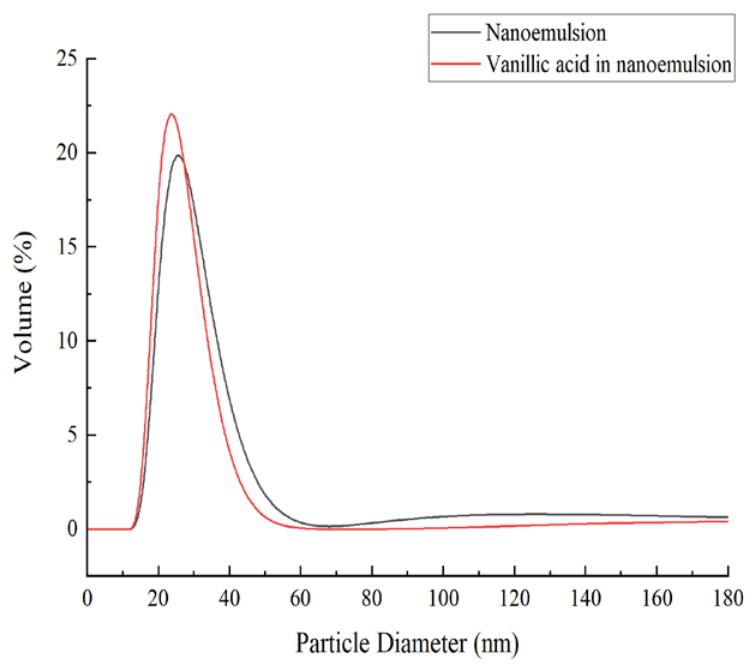
Figure 6. Particle size distributions for nanoemulsion and Amomum villosum extract nanoemulsion.